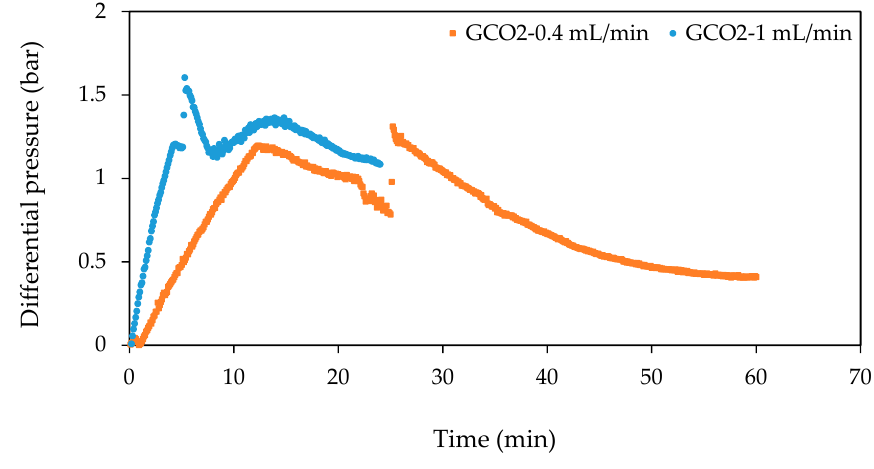
Figure 13. Effect of injection rate on the differential pressure profile of low-pressure GCO 2 –oil displacements conducted at 40 bar and 33 °C.